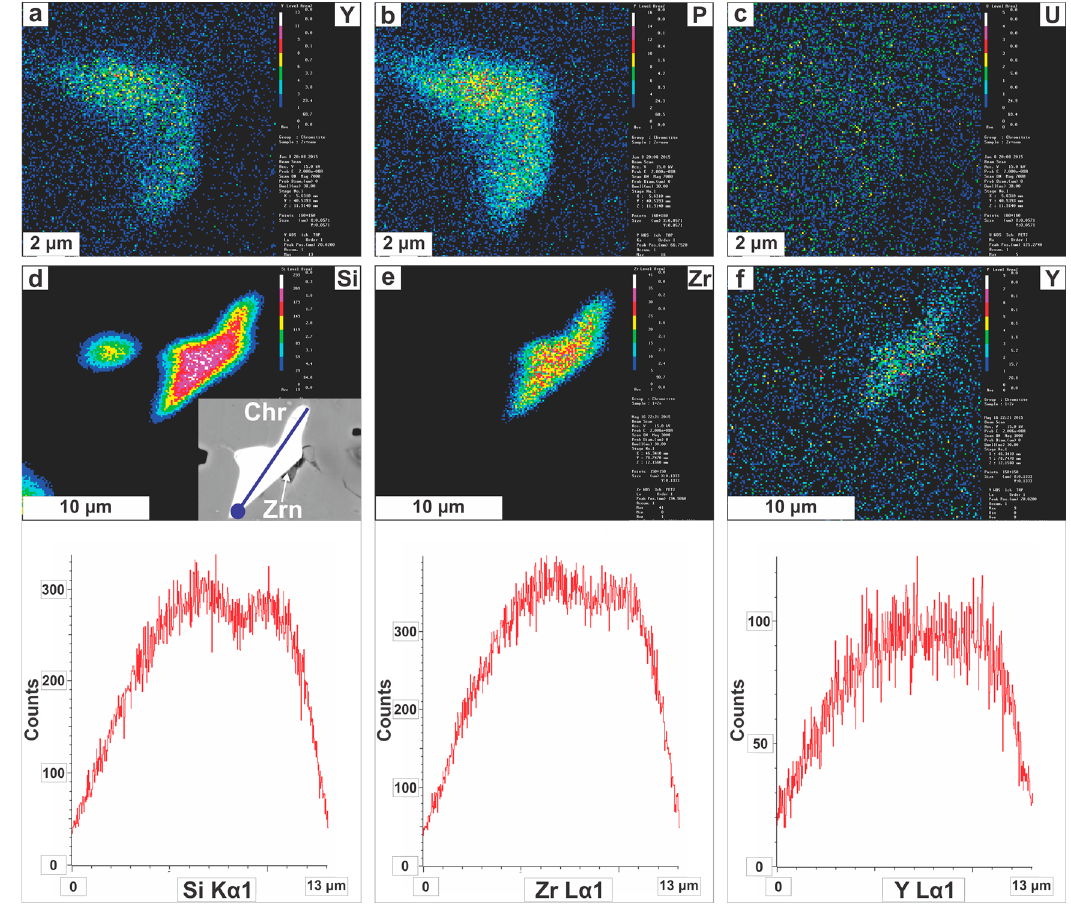
Figure 9. ( a – c ) Single-element (WDS) X-ray maps of the zircon grain originally illustrated in Figure 6a; ( d – f ) Single-element (WDS) X-ray maps of the zircon grain originally illustrated in Figure 7c (marked by the red square). Line scans are also shown for the zircon crystal depicted in Figure 6a, where the beginning of analyses is marked by the dark blue circle. Abbreviations are as in Figures 4 and 6.